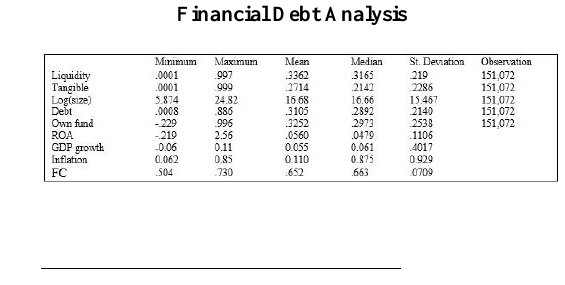
Table 1: Descriptive Statistics